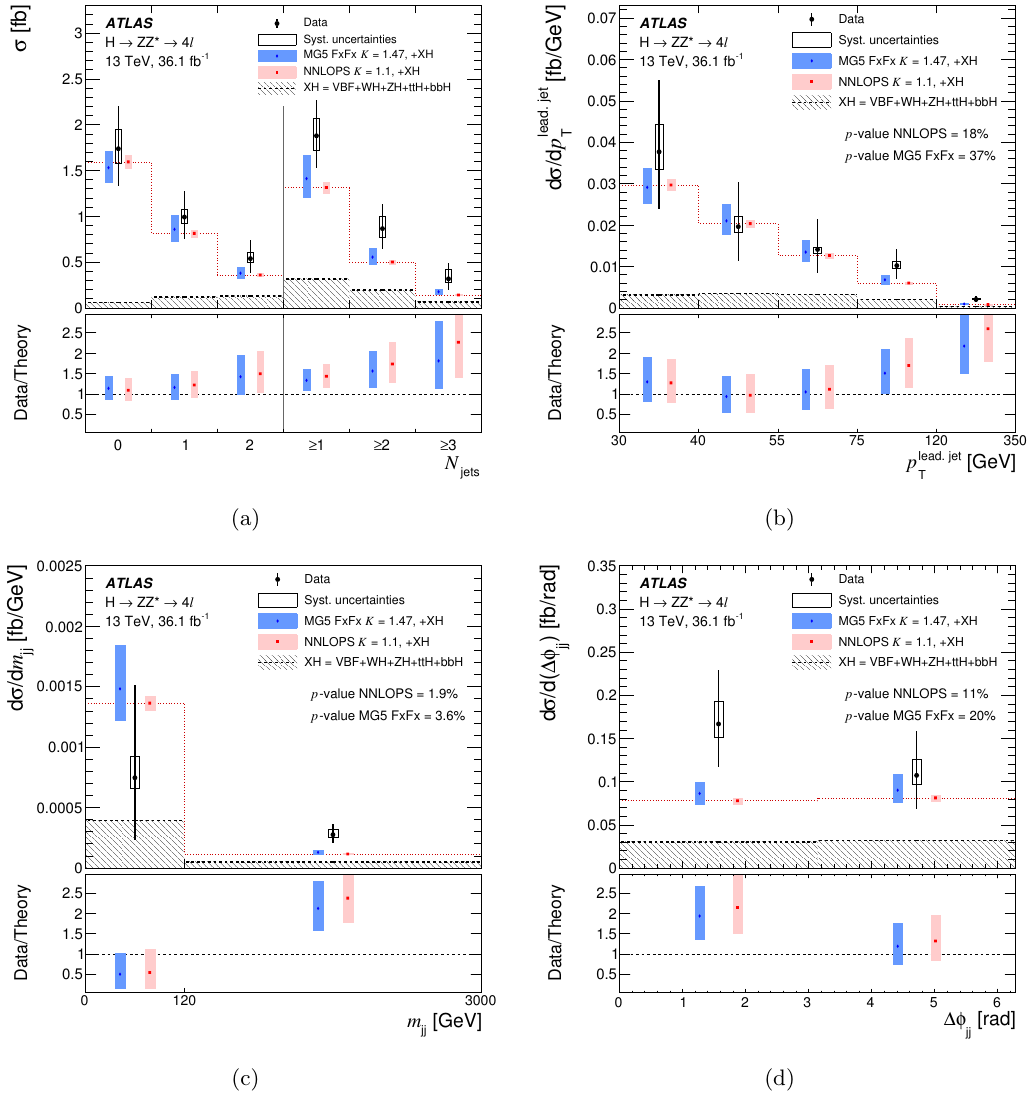
Figure 9. Di(cid:11)erential (cid:12)ducial cross sections, for (a) the number of jets N jets , (b) the transverse momentum p lead : jet of the leading jet, (c) the invariant mass of the two leading jets m jj , (d) the T angle between the two leading jets in the transverse plane (cid:1) (cid:30) jj . The measured cross sections are compared to ggF predictions by NNLOPS and MG5 aMC@NLO FxFx , all normalized to the N3LO cross section with the listed K -factors. Predictions for all other Higgs boson production modes XH are added. The error bars on the data points show the total uncertainties, while the systematic uncertainties are indicated by the boxes. The shaded bands on the expected cross sections indicate the PDF and scale uncertainties. The p -values indicating the compatibility of the measurement and the SM prediction are shown as well. They do not include the systematic uncertainty in the theoretical predictions.